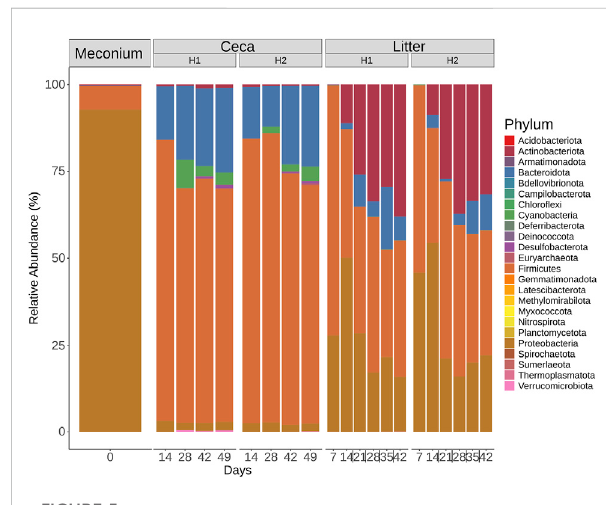
Phylum-level classi fi cation of 16S rRNA gene sequence reads. Samples were grouped by days and split by sample type (Meconium,